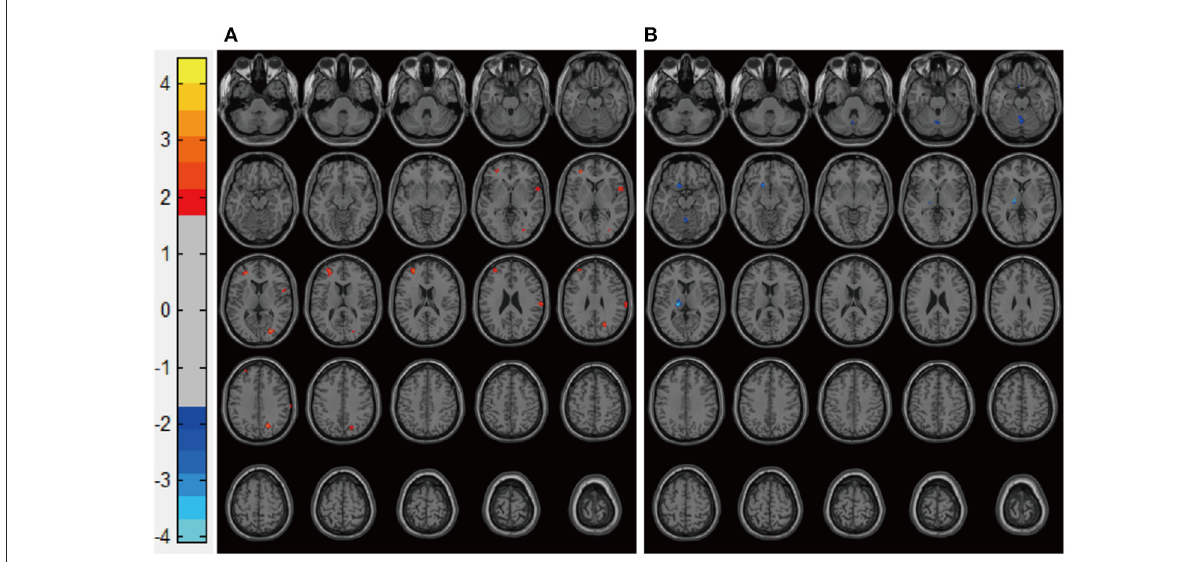
FIGURE4 Representative images of post-treatment rs-CBF in patients with BP experiencing their first manic episodes. (A) MA/Li, (B) MA/VPA. rs-CBF, resting-state cerebral blood flow; BP, bipolar disorder; MA, patients with BP experiencing their first manic episodes; MA/Li, treatment with lithium; MA/VPA, treatment with